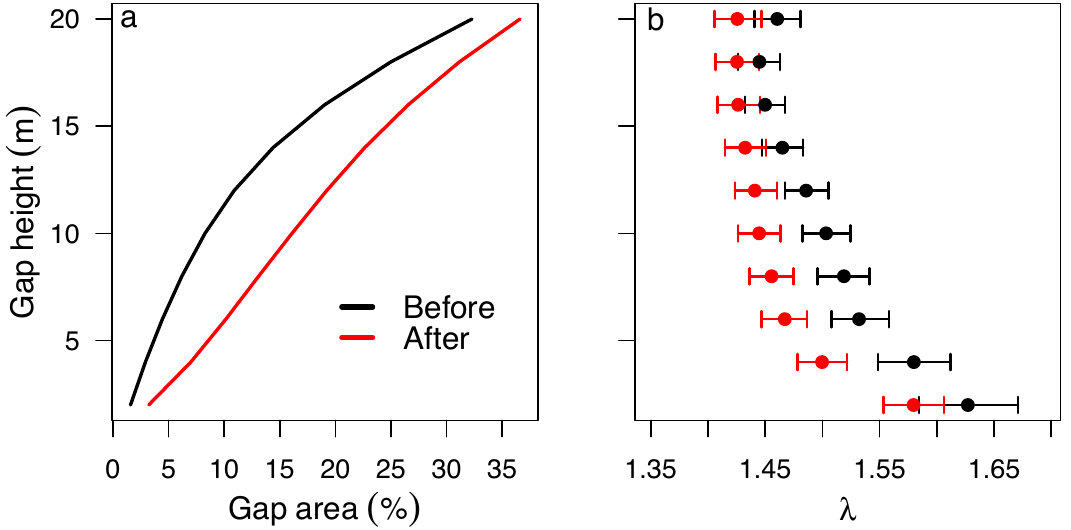
Figure 2. Total gap area ( a ) and the gap size-frequency distribution scaling exponent, (cid:31) , ( b ) before and after the tropical forest moderate blowdown. Gap statistics were calculated using maximum height thresholds from 2 to 20 m in height in 2 m intervals. Gap area ( a ) is shown as a percentage of the total 103.5 ha study area. Error bars ( b ) denote the 95% Bayesian credible intervals for (cid:31) .